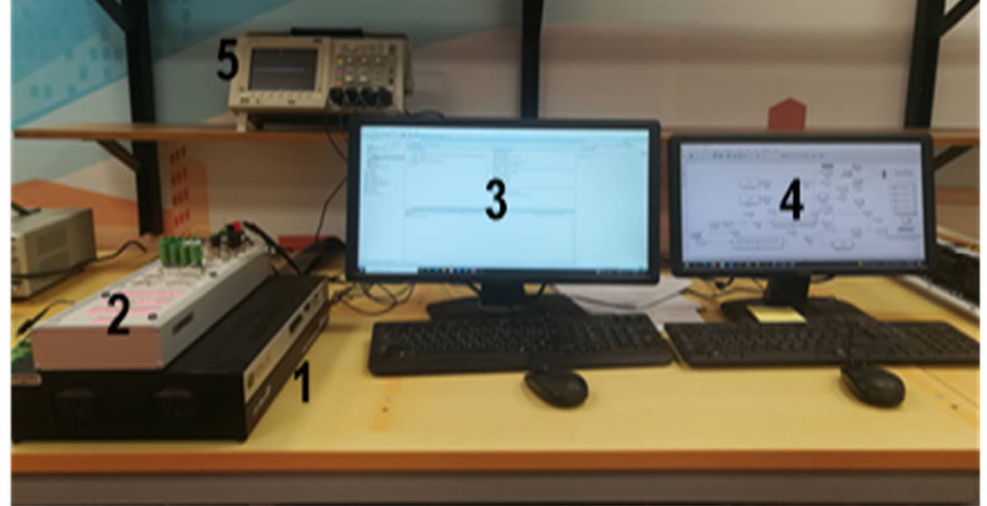
Figure 12. The experimental testbed. 1—OP4510 simulator; 2—dSPACE ds1104 Controller Box; 3—RT-LAB monitor console; 4—dSPACE control desk monitor; 5—Digital oscilloscope.